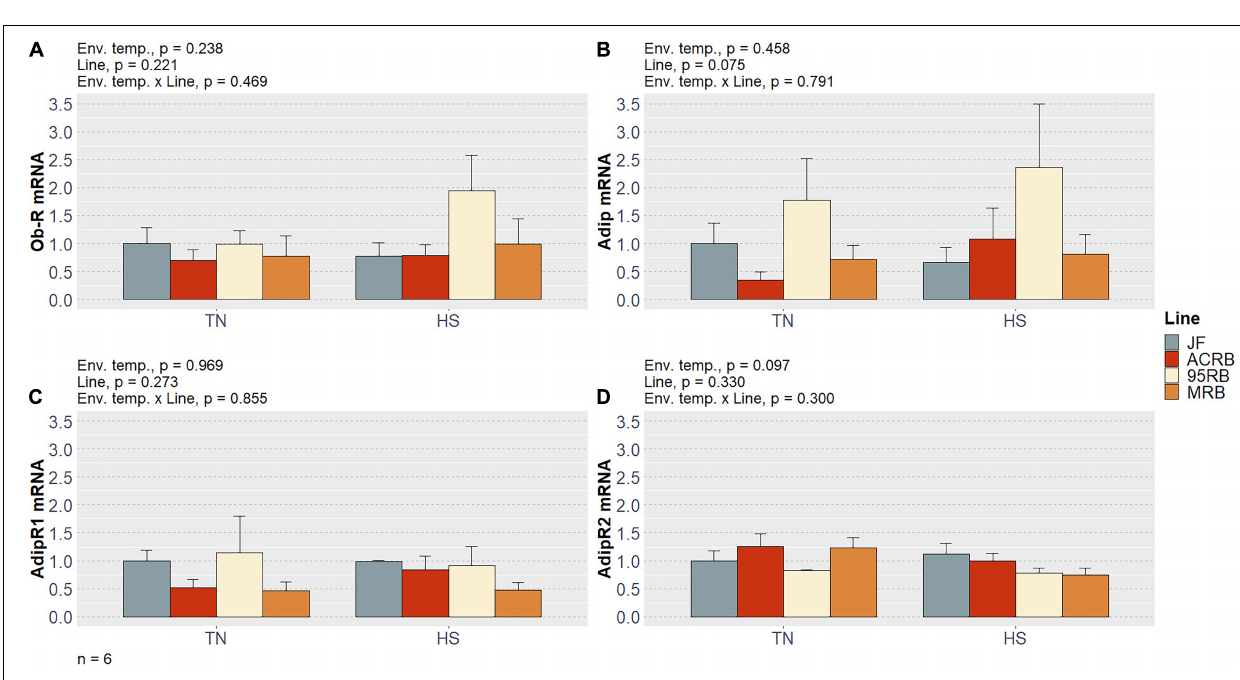
FIGURE 5 | Effect of cyclic heat stress on the hypothalamic expression of adiponectin system and leptin receptor in JF and modern broilers. The expression of Ob-R (A) , Adip (B) , Adip-R1 (C) , and Adip-R2 gene (D) was determined by qPCR using 2 − (cid:49)(cid:49) Ct method. JF-TN group was used as a calibrator. Data are mean ± SEM ( n = 6 birds/group). HS, heat stress; TN,